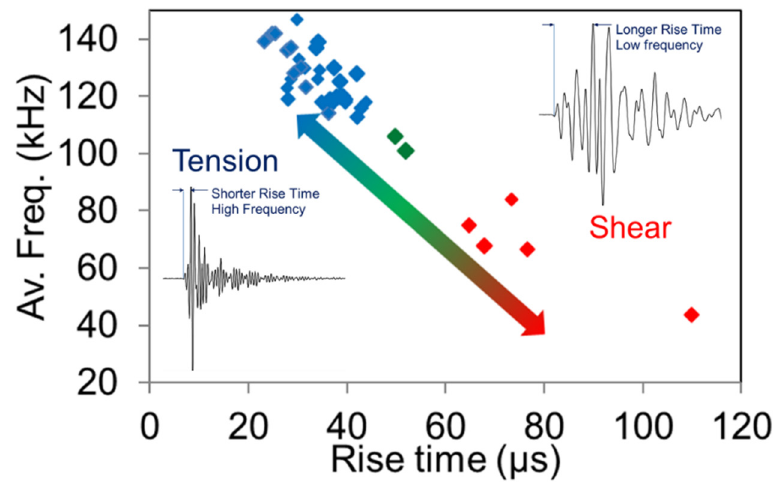
Figure 1. Average frequency–rise time plot from bending tests on TRC beams, taken from [7].